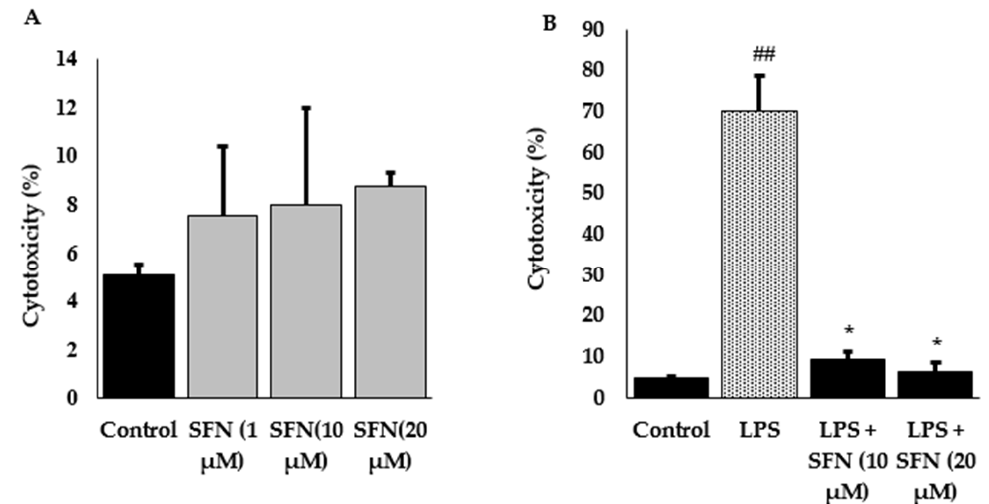
Figure 2. Raw 264.7 cells were exposed to various concentrations of SFN and the cytotoxicity was measured as % of LDH released into the culture supernatant. The relative LDH release is calculated by the ratio of LDH release over control sample. Di ff erent concentrations of SFN (0–20 µ M) treated in raw 264.7 cells showed non-significant results compare to the control ( A ). On the other hand, pre-treatment with SFN for 6 h, then administration of LPS for 24 h showed a significant reduction of LDH release as compared to LPS alone ( B ). The results are expressed as mean ± standard error (SE) (## p <